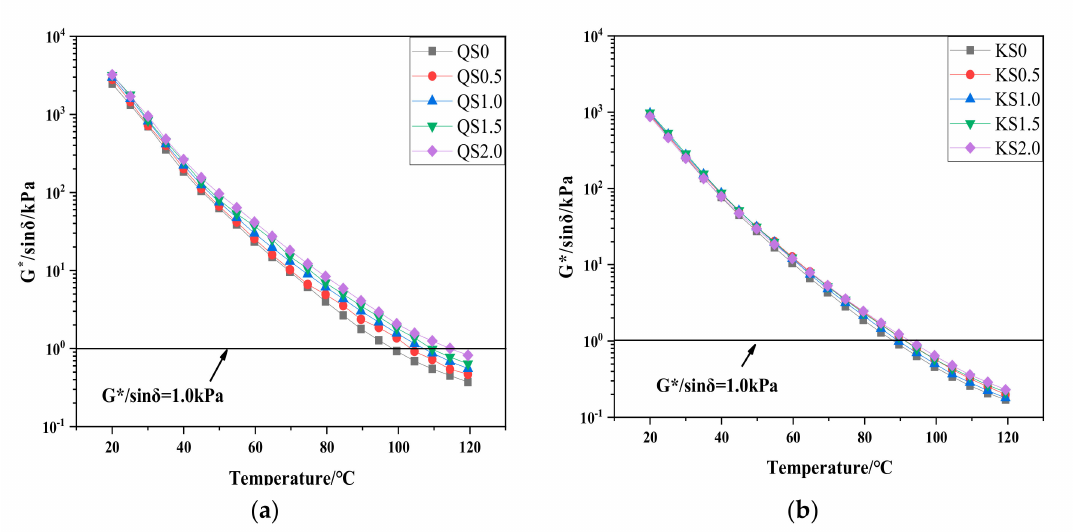
Figure 6. Failure temperature of rubber asphalt with different WS-1 content when rutting factor G*/sin δ = 1.0 kPa: ( a ) The G*/sin δ of QS warm mix rubber asphalt; ( b ) The G*/sin δ of KS warm mix rubber